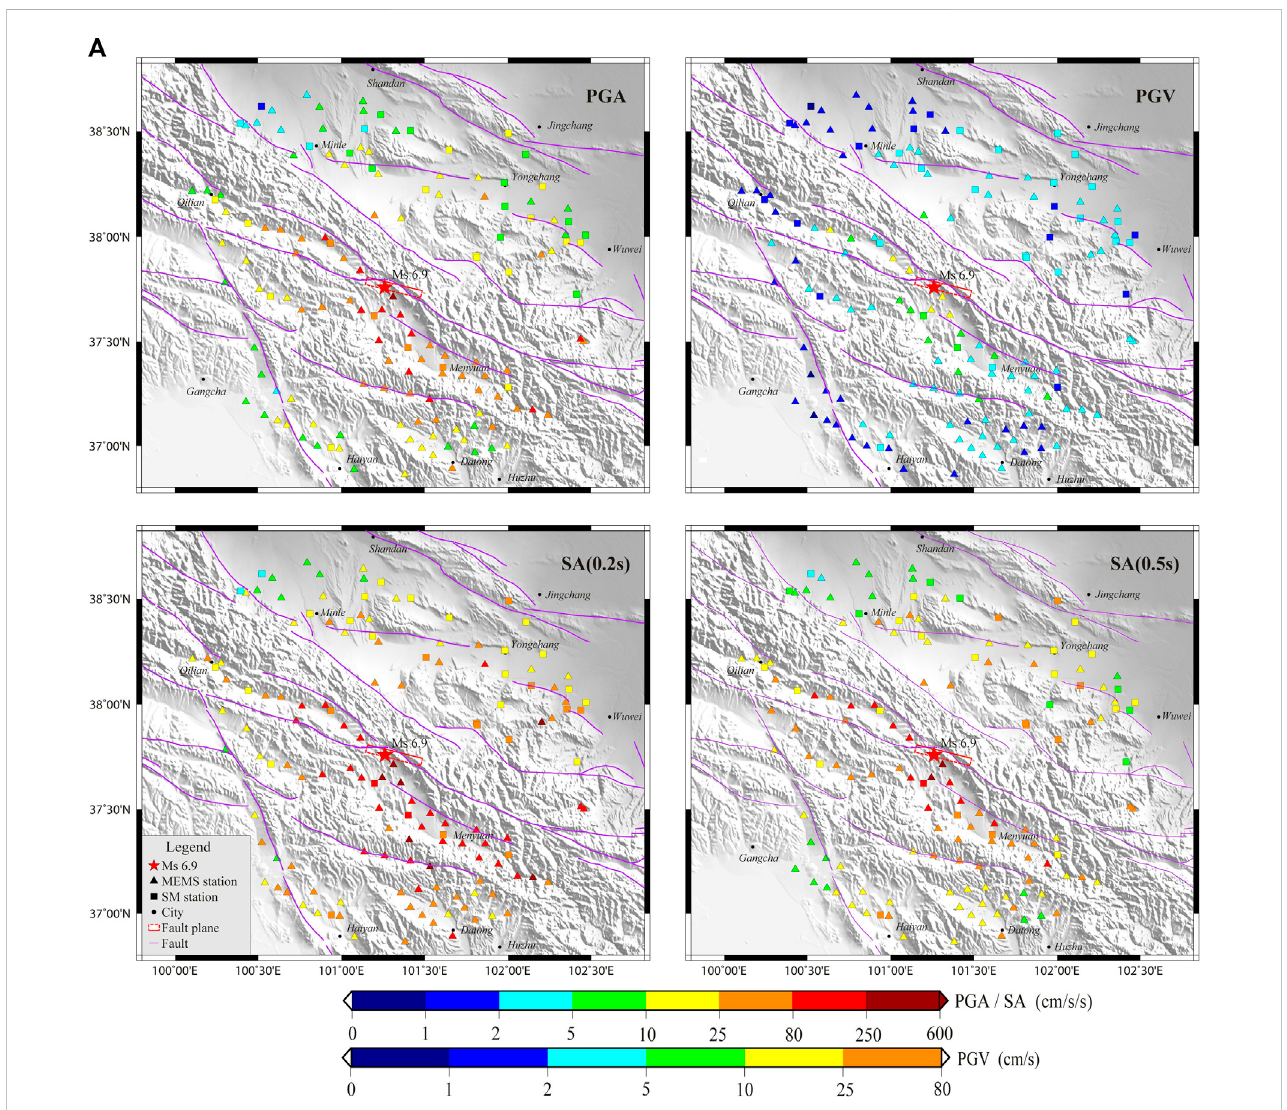
FIGURE 5 Spatial distribution of IMs. (A) PGA, PGV, and short-period ground motion for less than 1.0 s (B) long-period ground motion for > 1.0 s.